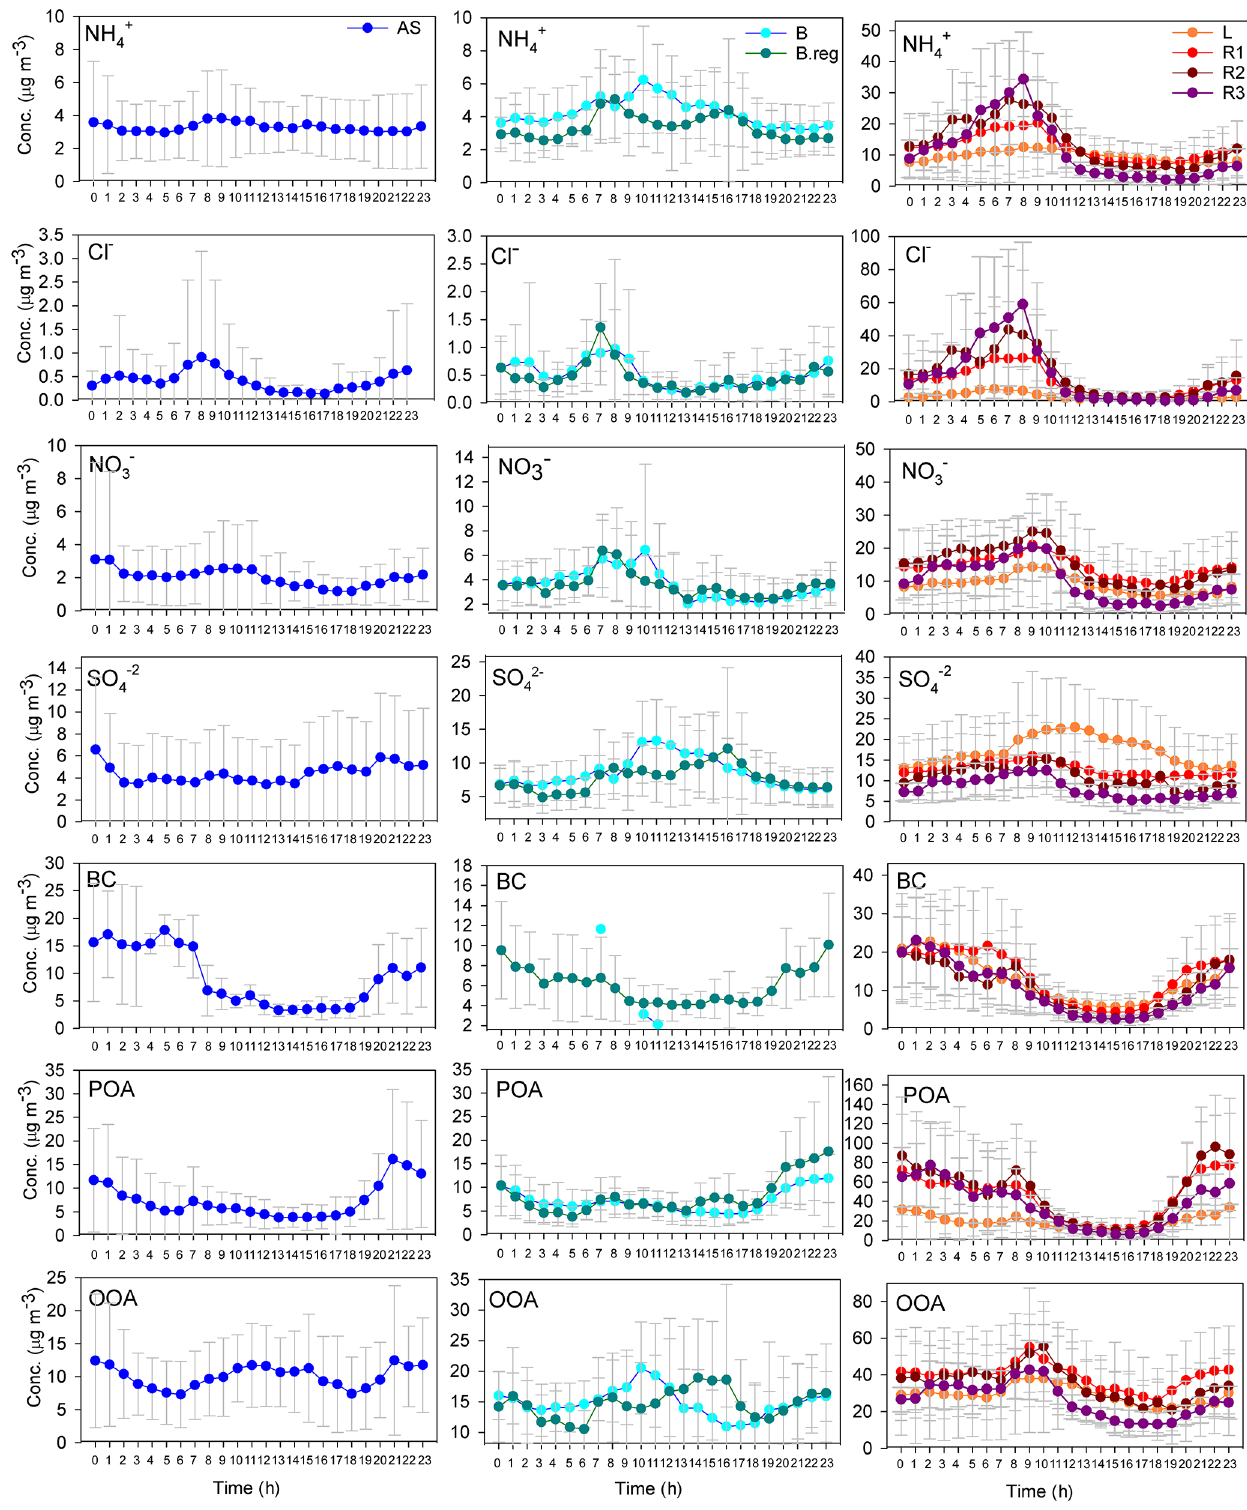
Figure 3. Diurnal variation in NRPM 1 species (NH + the middle, and SA (L, R1, R2, and R3) air masses on the